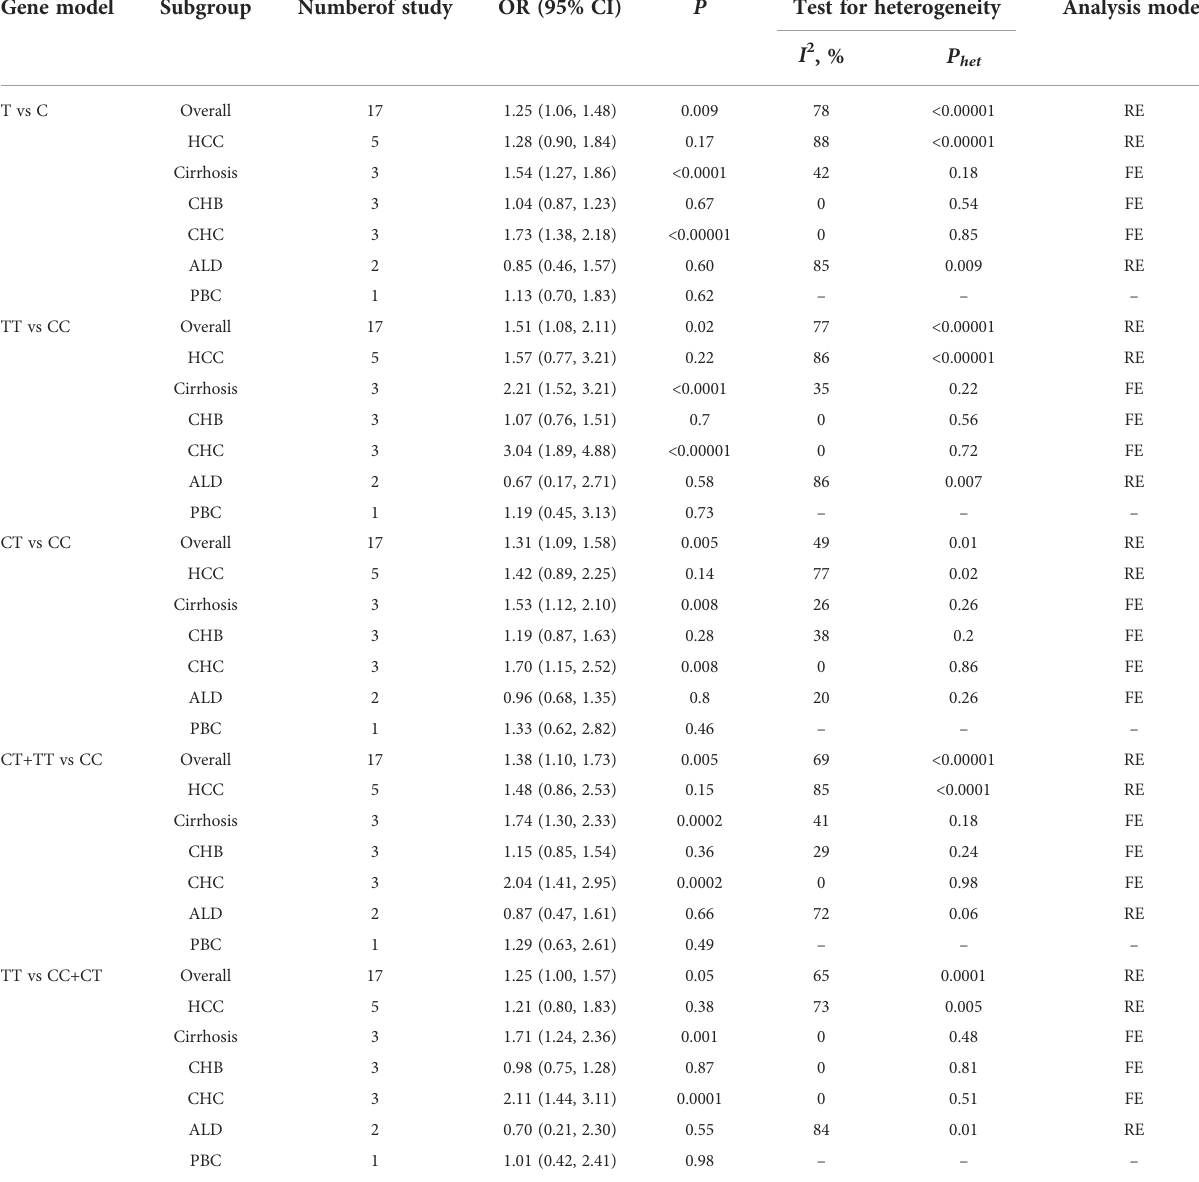
TABLE 6 Subgroups results of the role of TGF- b 1 -509C/T polymorphism in different CLDs. Gene